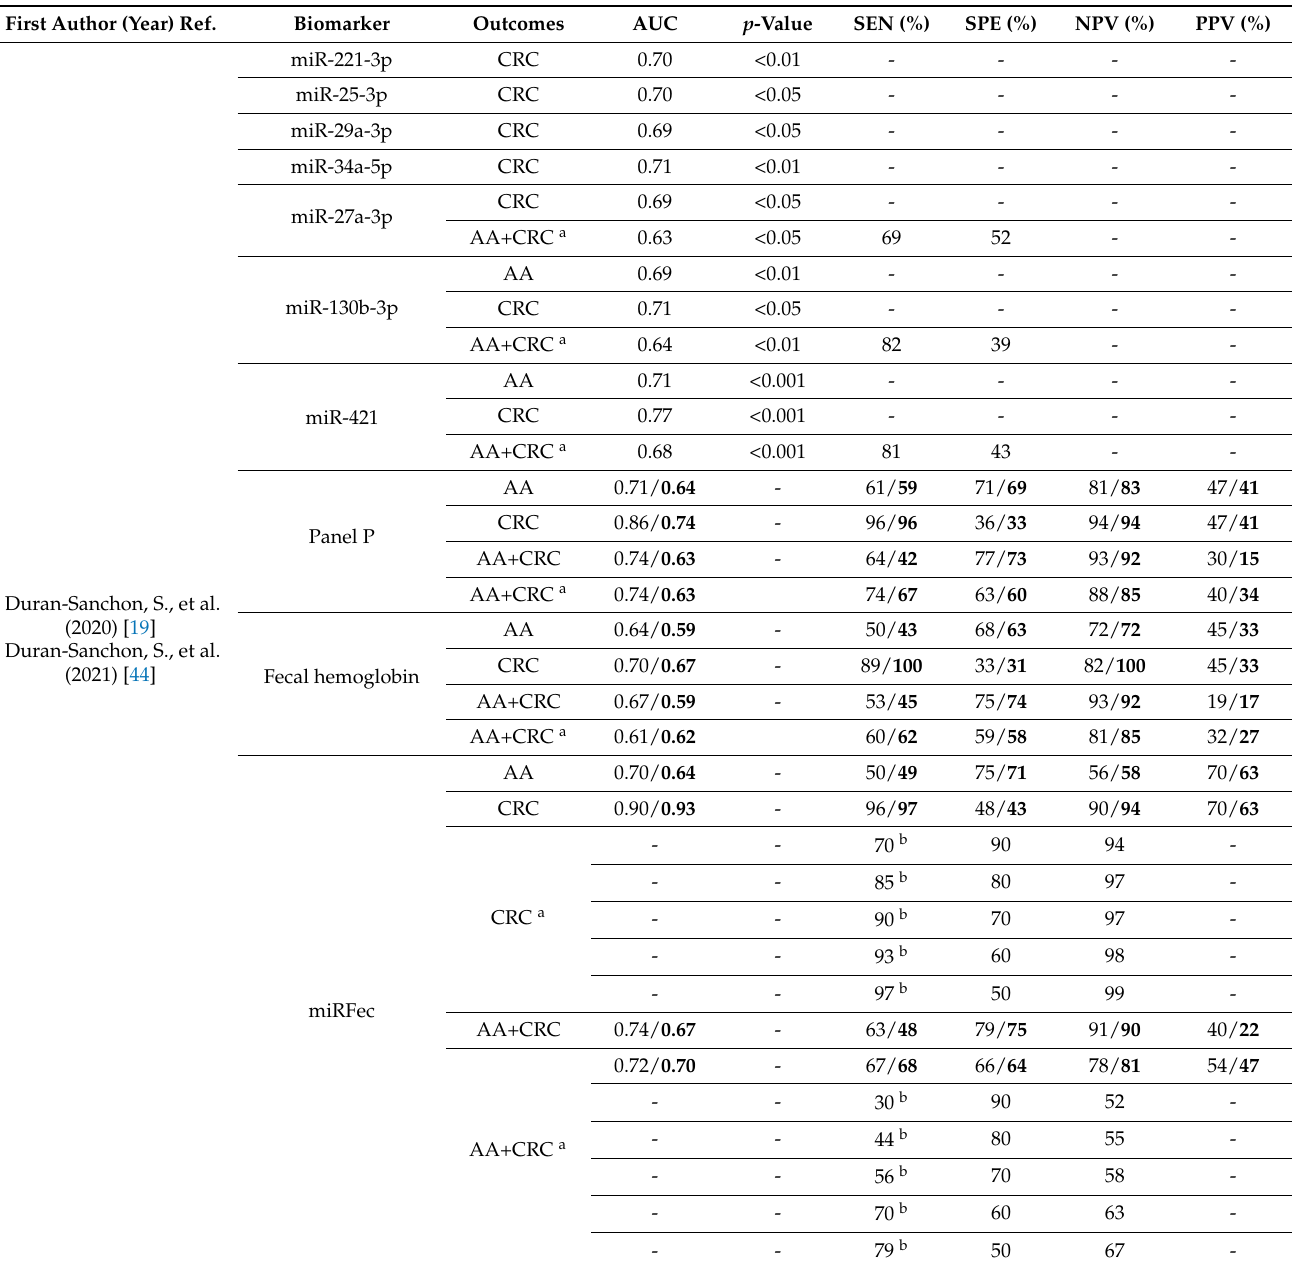
Table 4. Diagnostic performance of fecal miRNAs for CRC and CRA composed of FIT-positive